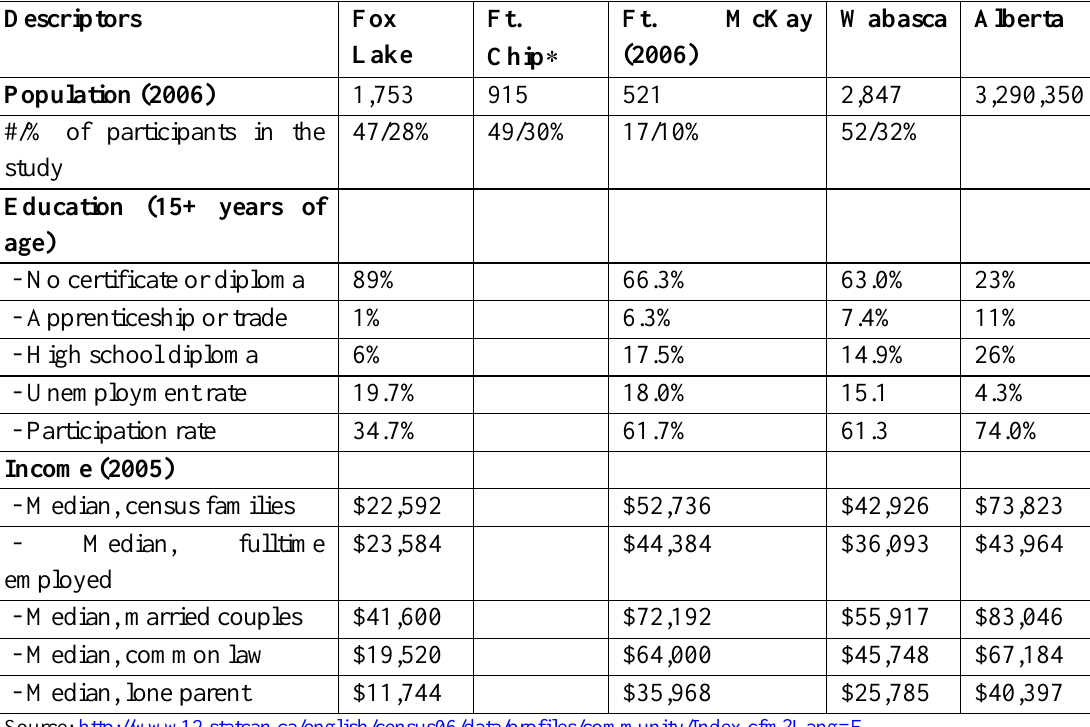
Demographic, Educational, and Economic Descriptors of the Target